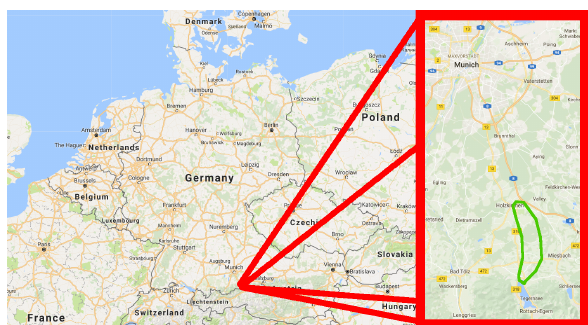
Figure 5. The scanned region (Photos from Google maps). In the Background: whole Germany and parts of Europe, in the zoomed part (red rectangle): the scanned Mangfall area (marked in green) from the Tegernsee in the south to the highway in the north.